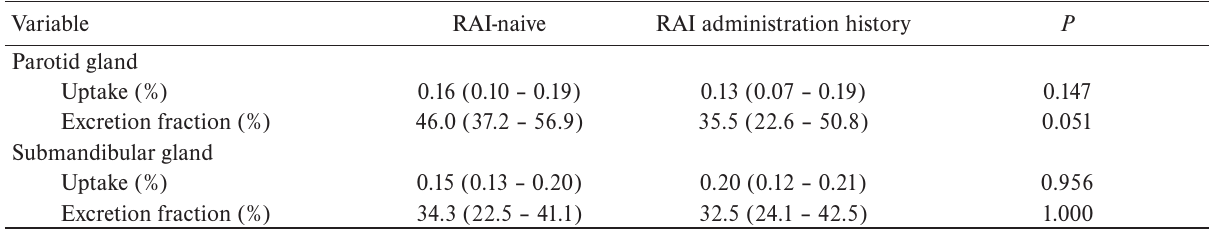
Table 2. Comparison of 99m Tc-pertechnetate uptake and secretion in salivary glands between patients with RAI administration history (all activities, n=23) versus their age- and sex-matched RAI-naive counterparts (n=23). Variable RAI-naive